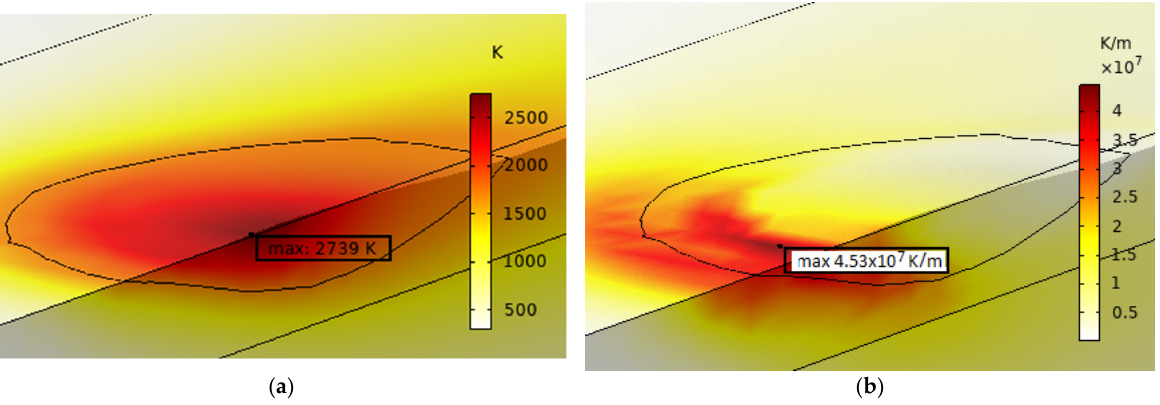
Figure 9. Characteristics of the molten pool calculated under condition of the alternating magnetic field: ( a ) temperature field and ( b ) distribution of the temperature gradient.